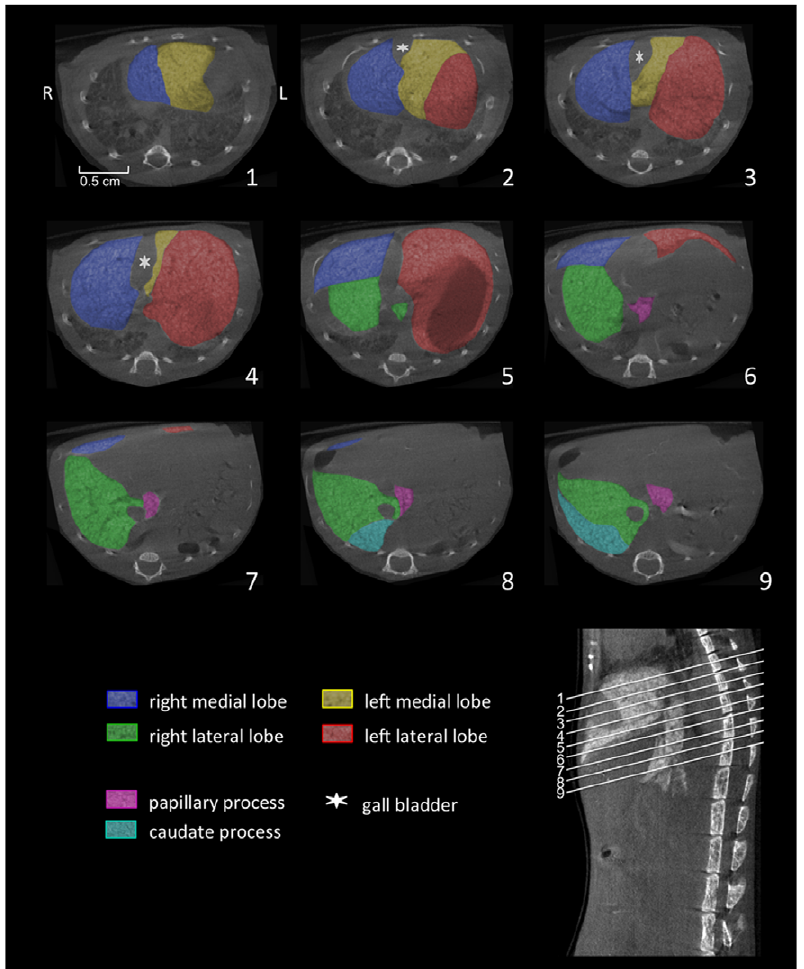
Figure 4. Axial reconstructed micro-CT images. Micro-CT of the liver of a C57BL/6J mouse was performed 3 hours after injection of a nanoparticular contrast agent (ExiTron nano). The color-coding of the single liver lobes corrsponds to the color coding presented in Figure 1. The orientation of the axial slices in relation to the spine is shown in the lower right corner.